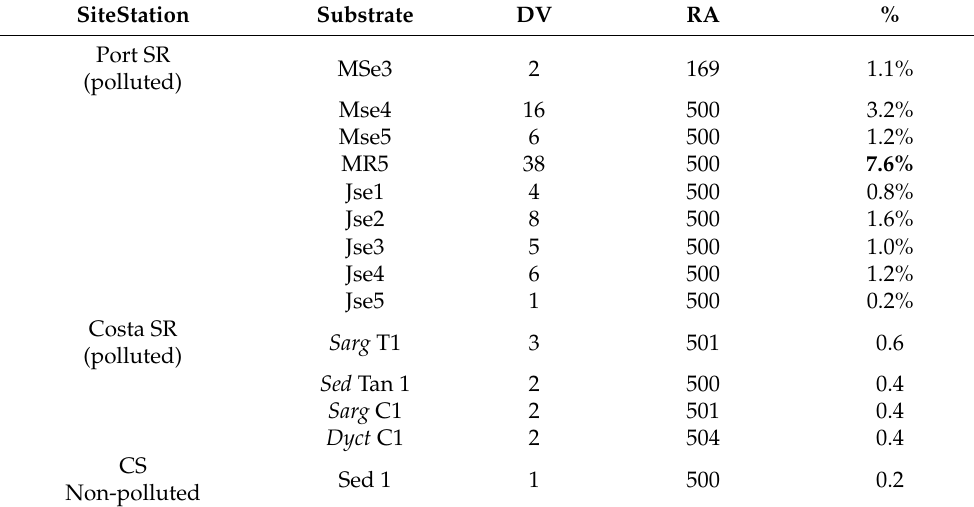
Table 6. Proportions of deformed valves of diatoms collected at Port and Costa (SR), and CS. DV = deformed valves, RA = relative abundances, M = May, J = January, Se = Sediment, R = rock, # = sampling